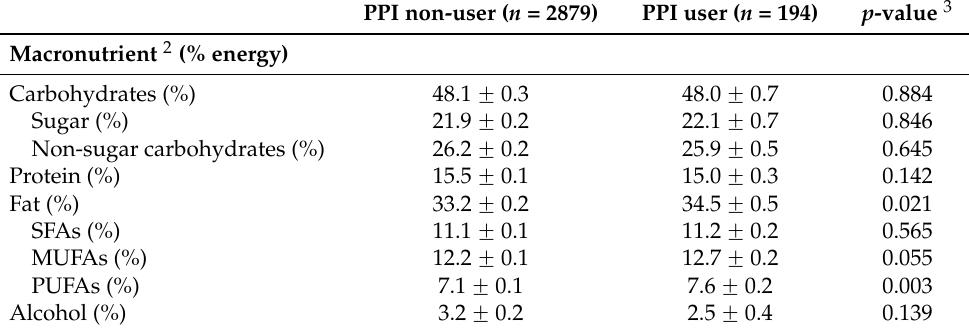
Table 2. Diet composition by use of a proton pump inhibitor (PPI) from the 2005–2006 NHANES 1